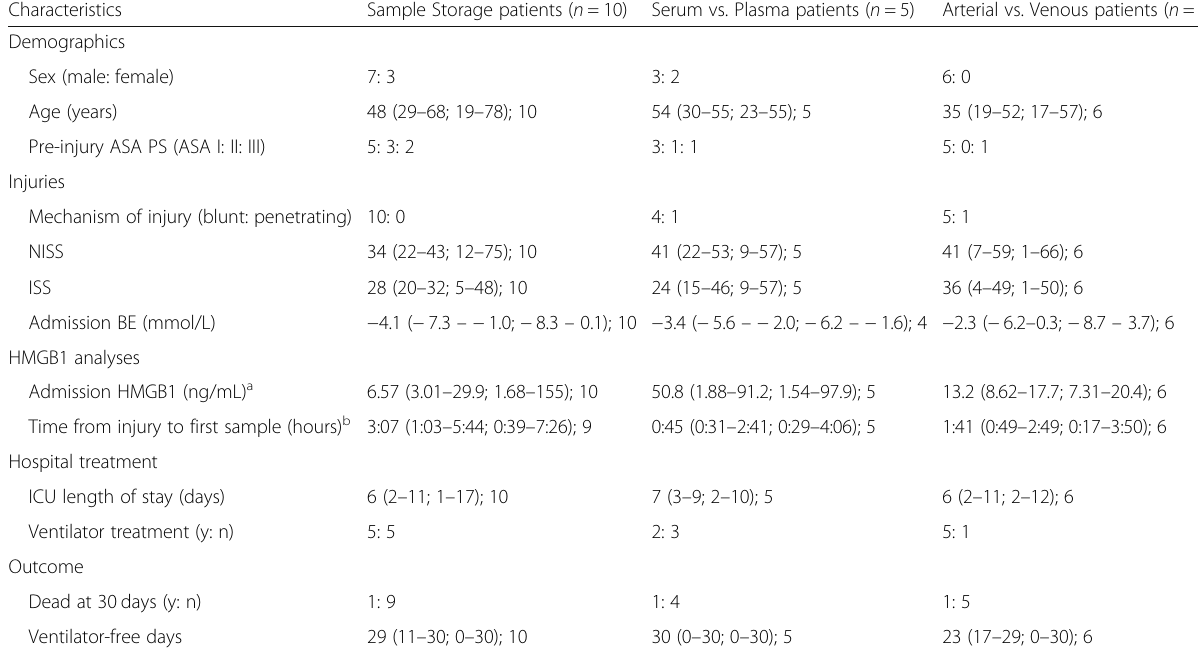
Table 1 Characteristics of the three study populations Characteristics Arterial vs. Venous patients ( n = 6)